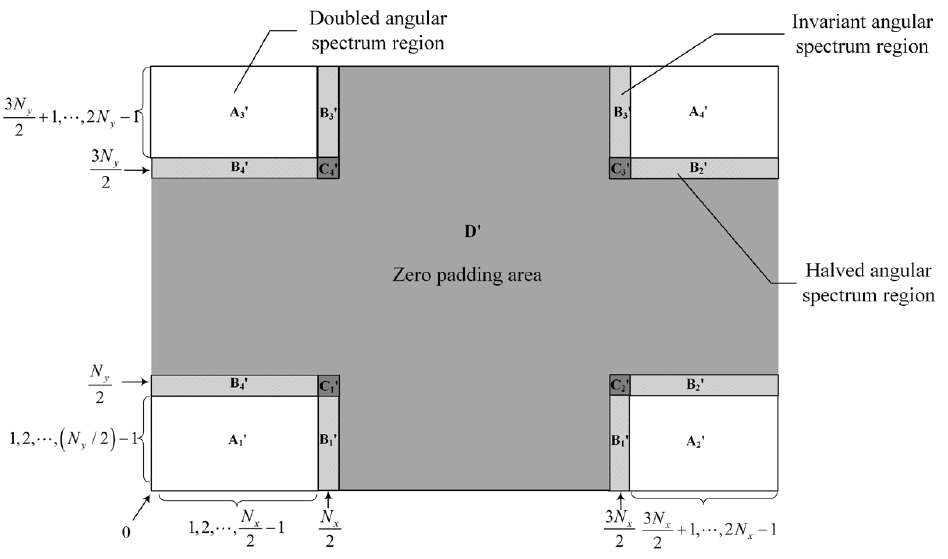
Figure 3. Regional division of the generated angular spectrum.